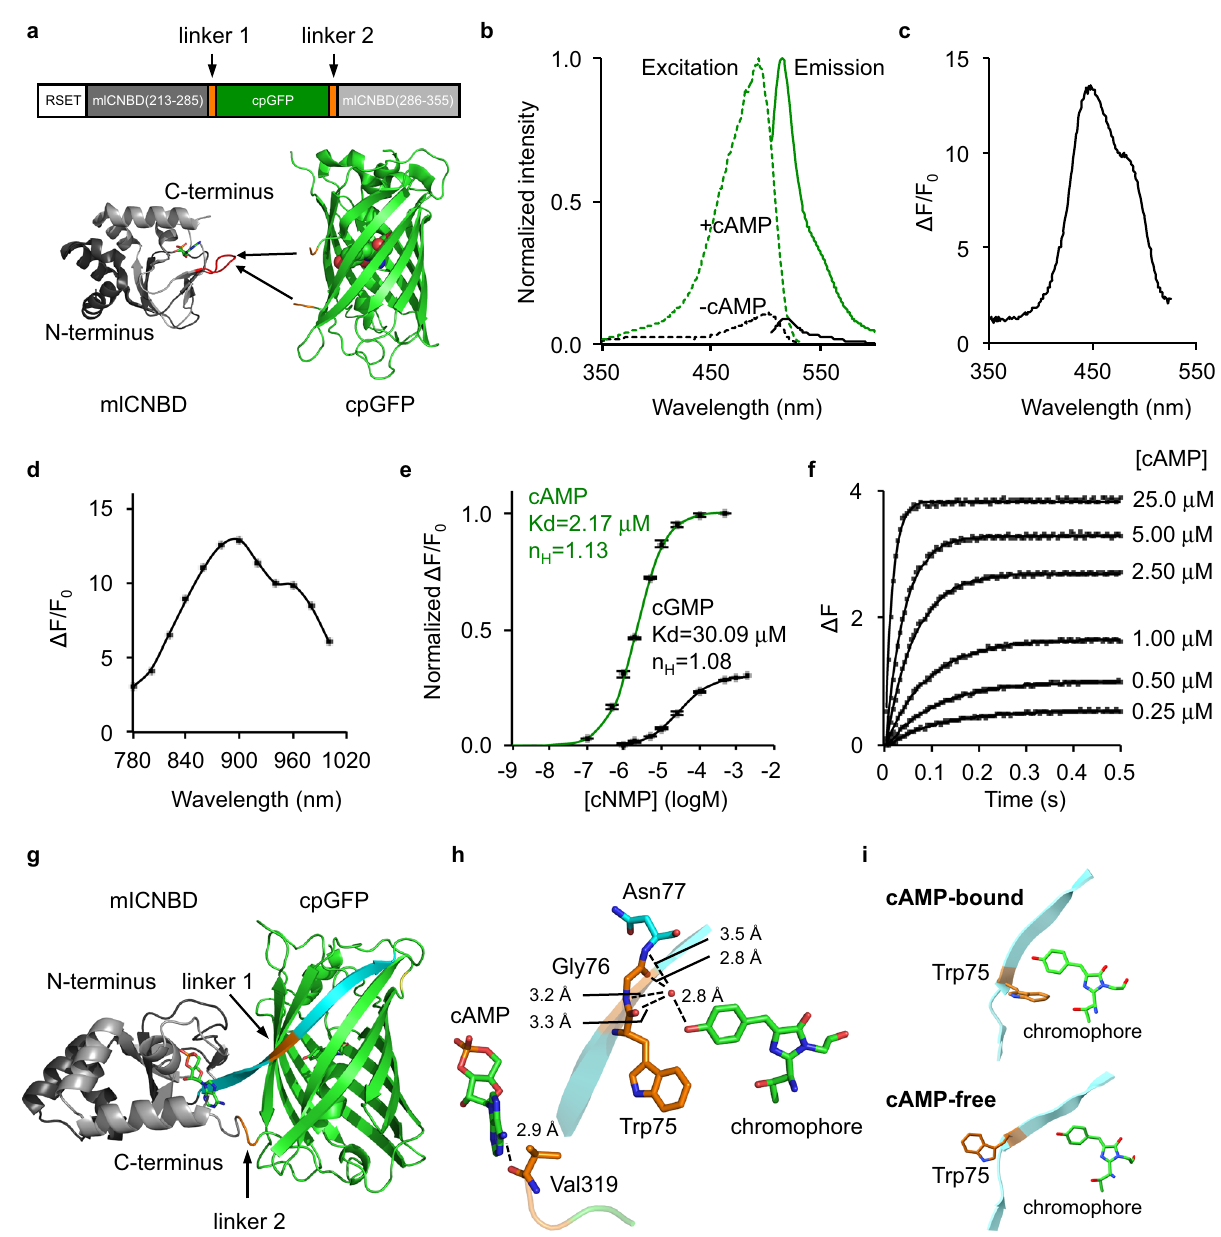
Fig. 1 | Development and in vitro characterization of G-Flamp1 indicator. a Schematic of G-Flamp sensors. cpGFP with two fl anking linkers (two amino acids per linker) is inserted into mlCNBD (Gly213-Ala355, Genbank accession number: BA000012.4). The N-terminal peptide (RSET) including a 6× His tag is from the bacterial expression vector pNCS. The X-ray crystal structures of cAMP-bound mlCNBD(PDB:1VP6)andcpGFP(PDB:3WLD)areshownascartoonwithcAMPand chromophore of cpGFP shown as stick and sphere, respectively. The loop bearing theinsertionsiteinG-Flamp1ismarkedinred. b Excitationandemissionspectraof cAMP-free and cAMP-bound G-Flamp1 sensors in HEPES buffer (pH 7.15). c Excitation wavelength-dependent Δ F /F 0 of G-Flamp1 under one-photon excita- tion. d Excitation wavelength-dependent Δ F / F 0 of G-Flamp1 under two-photon excitation. e BindingtitrationcurvesofG-Flamp1tocAMPorcGMPinHEPESbuffer (pH 7.15). The data were fi tted by a sigmoidal binding function to extract the